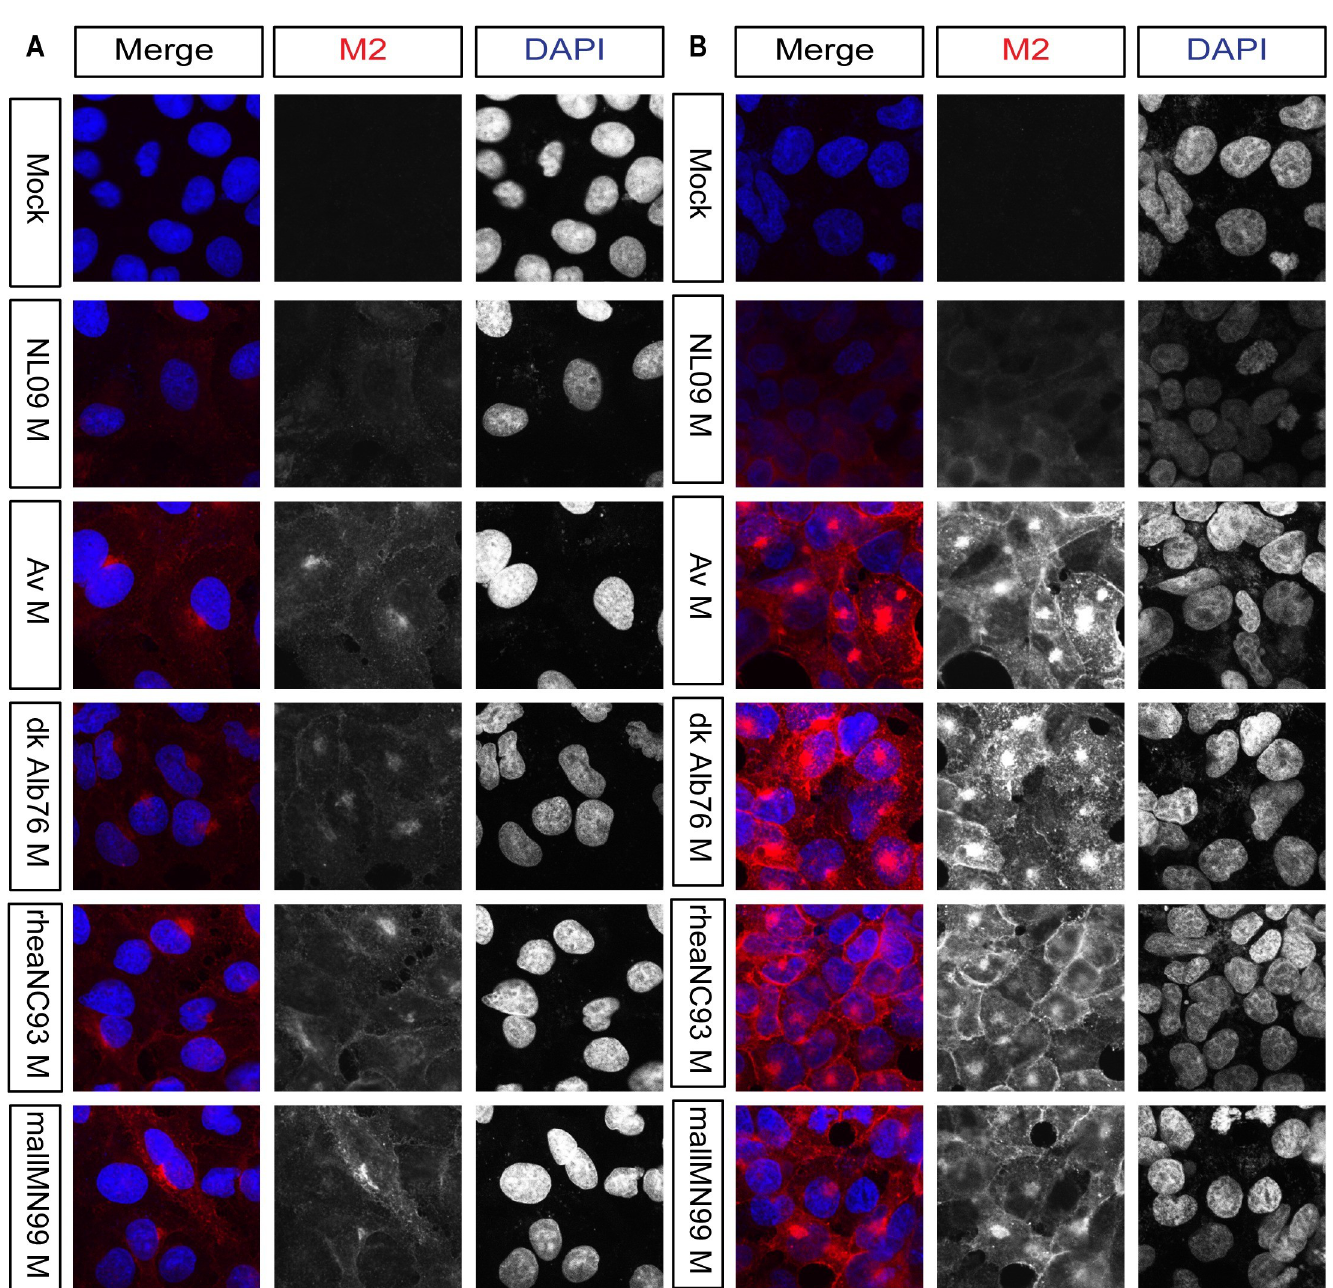
Fig 8. In human cells, avian M2 was expressed at higher levels and localized more strongly to perinuclear bodies than human M2. A549 and 293T cells were inoculated with the indicated viruses, encoding avian or human M segments, at a MOI of 5 PFU/cell. At 8 hpi cells were stained with anti-M2 (Mab E10; red) and DAPI (blue) and imaged by confocal microscopy. Examples of optical sections are shown, either as merged 2-color images or the red and blue channels alone (shown in grey scale). (A) A549 cells with 63x optical and 3x digital magnification (189x total magnification). (B) 293T cells with 63x optical and 3x digital magnification (189x total magnification). Brightness was adjusted for optimal clarity, with all images treated